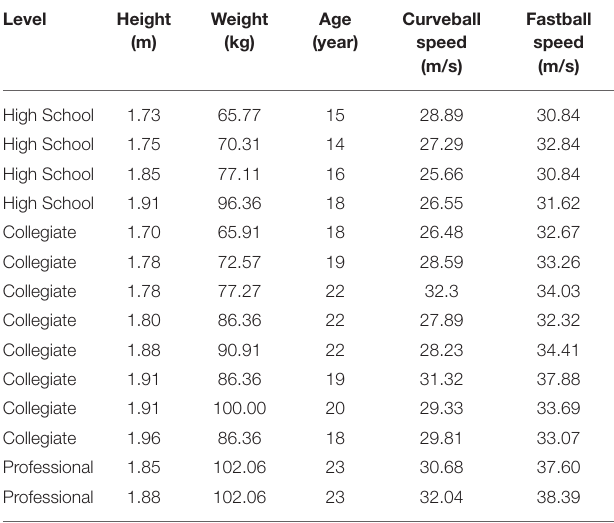
TABLE 1 | Pitcher characteristics and average pitch